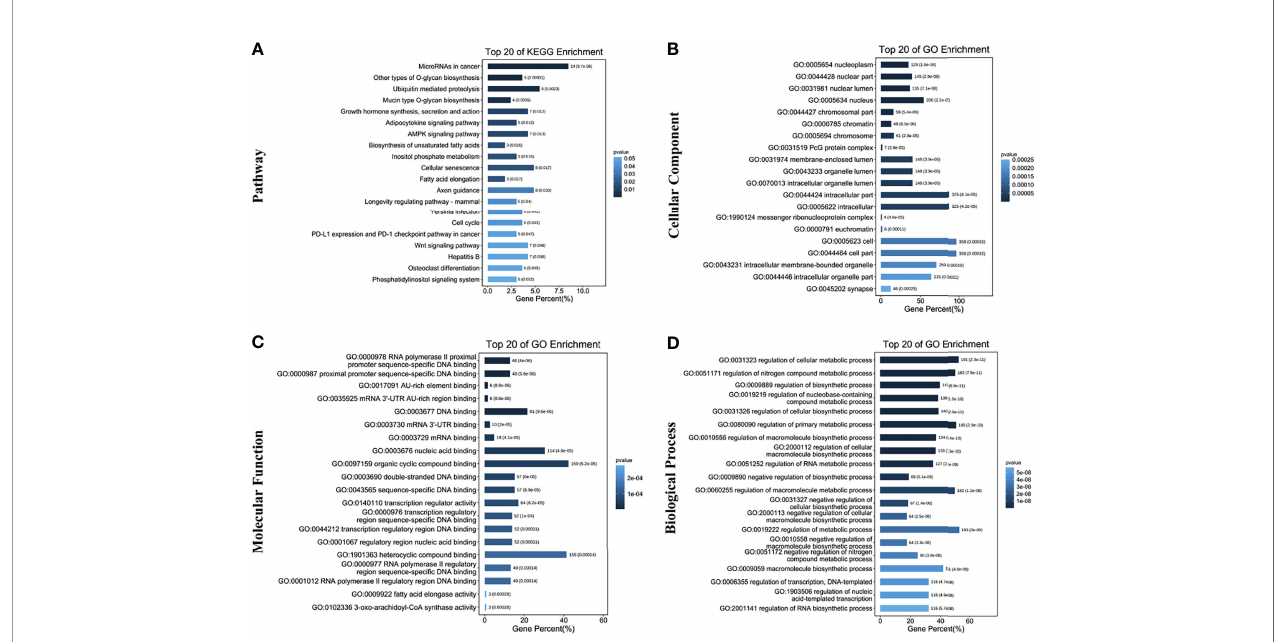
FIGURE 3 | Functional enrichment analysis of target genes. (A) Top 20 terms in the KEGG pathway enrichment; (B) Top 20 terms in the cellular component enrichment; (C) Top 20 terms in the molecular function enrichment; (D) Top 20 terms in the biological process enrichment.